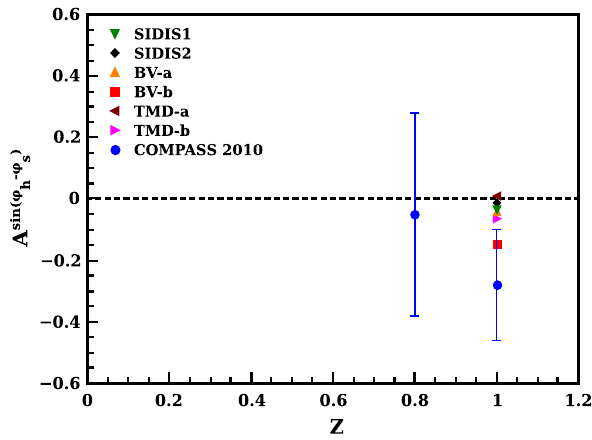
Fig. 6 Singlespinasymmetryin e + p ↑ → e + J /ψ + X processat z = √ s = 17 . 2 GeV (COMPASS) using DGLAP (SIDIS1, SIDIS2, 1 with BV-a and BV-b) and TMD (TMD-a and TMD-b) evolution approaches. The integration ranges are 0 < P hT < 1 . 0 GeV, 0 . 1 < y < 0 . 9 and 0 . 0001 < x B < 0 . 65. Data from [77]